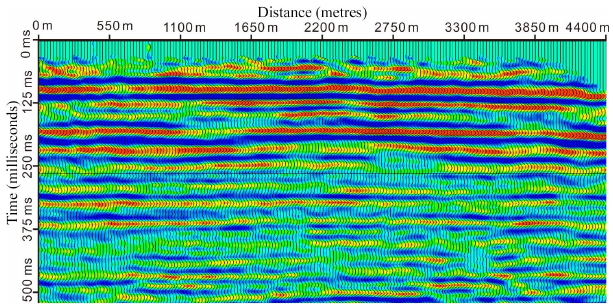
Figure 6. Seismic migration